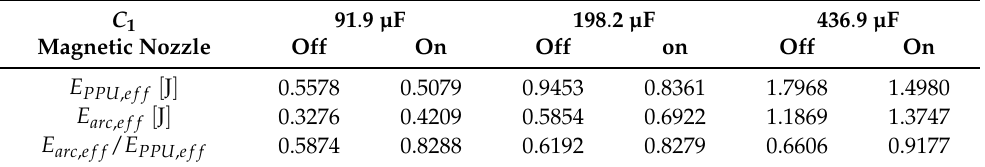
Table 1. Calculated energies stored in the PPU and measured dissipated arc energies for different energy storage configurations and additional magnetic fields. C 1 91 . 9 µF 198 . 2 µF 436 . 9 µF Magnetic Nozzle Off On Off on Off On E PPU , ef f [ J ] 0.5578 0.5079 0.9453 0.8361 1.7968 1.4980 E arc , ef f [ J ] 0.3276 0.4209 0.5854 1.1869 1.3747 E arc , ef f / E PPU , ef f 0.5874 0.8288